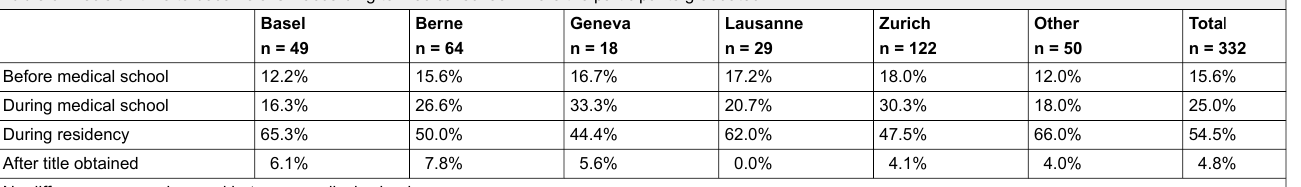
Table 3: Decision time to become a GP according to medical school where the participants